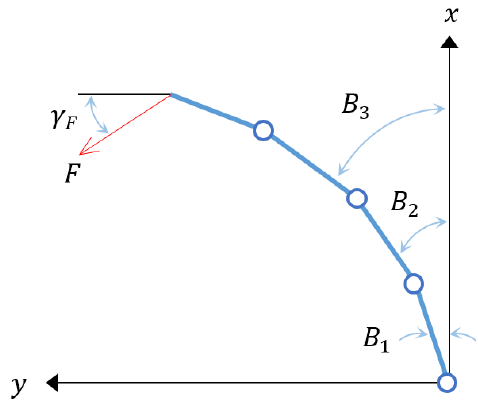
Figure 7. Schematic representation of the kinematics of the external loading experiment.